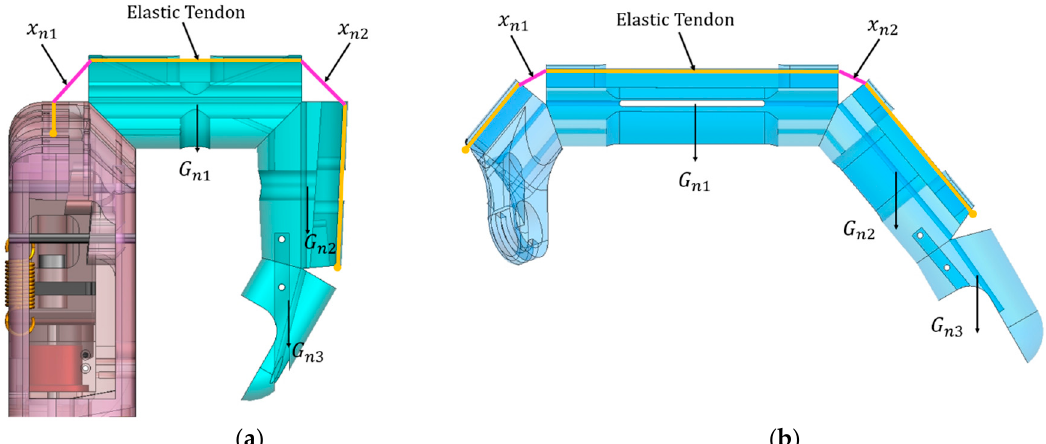
Figure 10. Fully flexed state: ( a ) fully flexed finger; ( b ) fully flexed thumb.